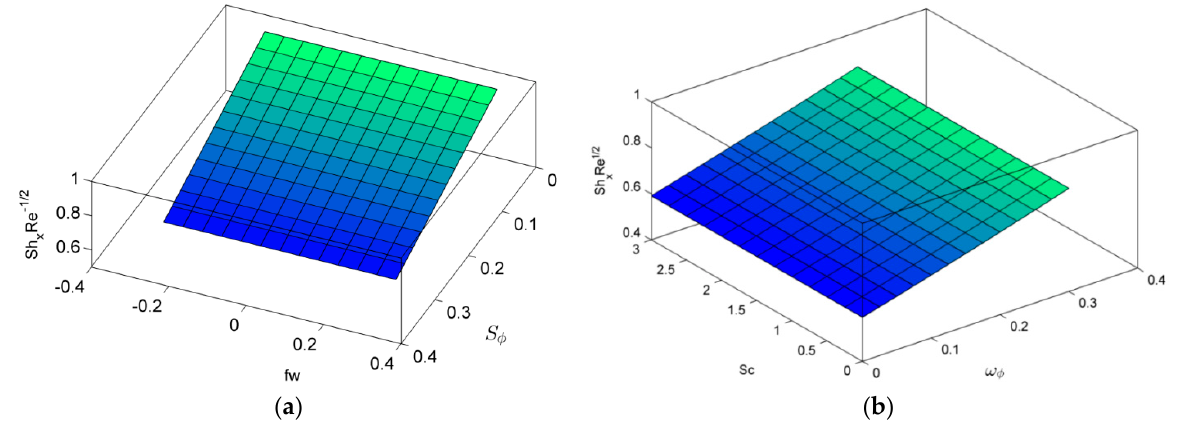
Figure 20. The 3D plot of Sherwood number for ( a ) fw and 𝑆 (cid:3109) , ( b ) Sc and 𝜔 (cid:3109)